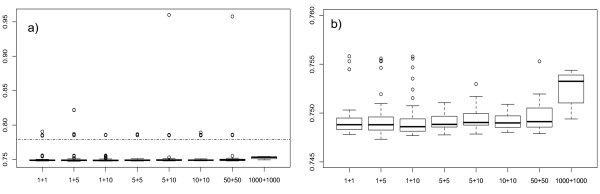
Relative fitness improvement by (λ + μ)-EAs. Boxplot representing the relative final fitness values for the (λ + μ)-EAs (a) and magnified in the range [0.745, 0.76] (b). The dotted line in a) is the threshold used to evaluate the computational effort and set at 0.78.